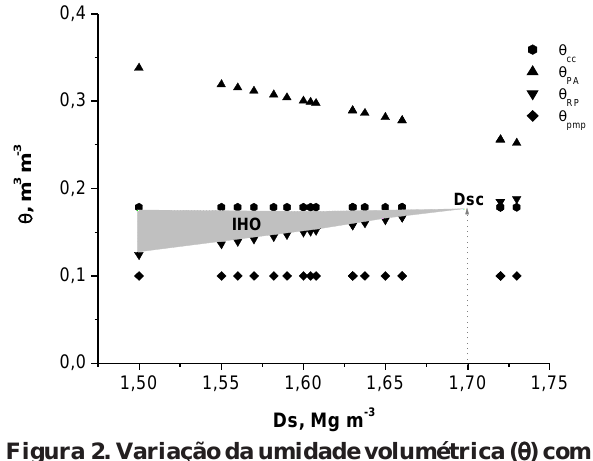
Figura 2. Variação da umidade volumétrica ( qqqqq ) com a densidade do solo (Ds), para os limites críticos de capacidade de campo ( qqqqq ( qqqqq ), porosidade de aeração ( qqqqq PMP do solo à penetração ( qqqqq hídrico